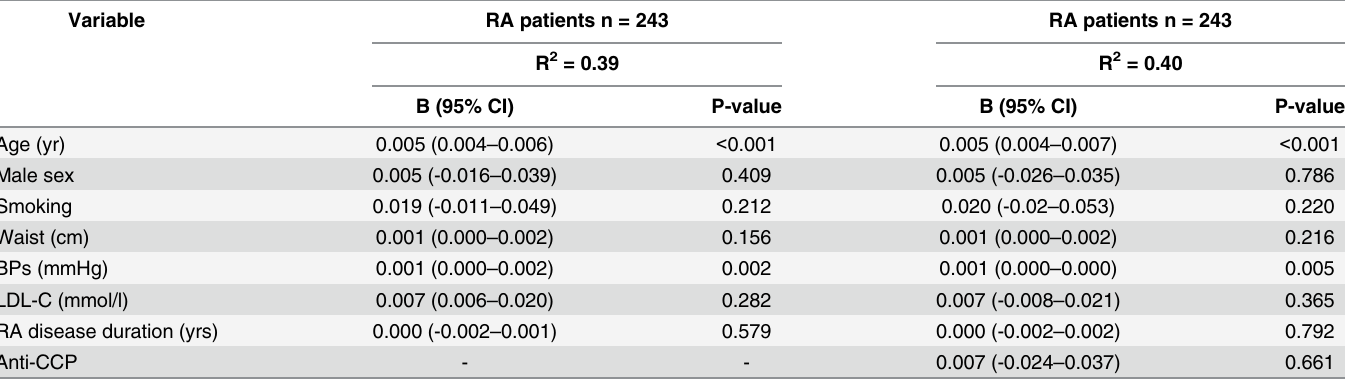
Table 4. Multivariable regression analysis including RA disease